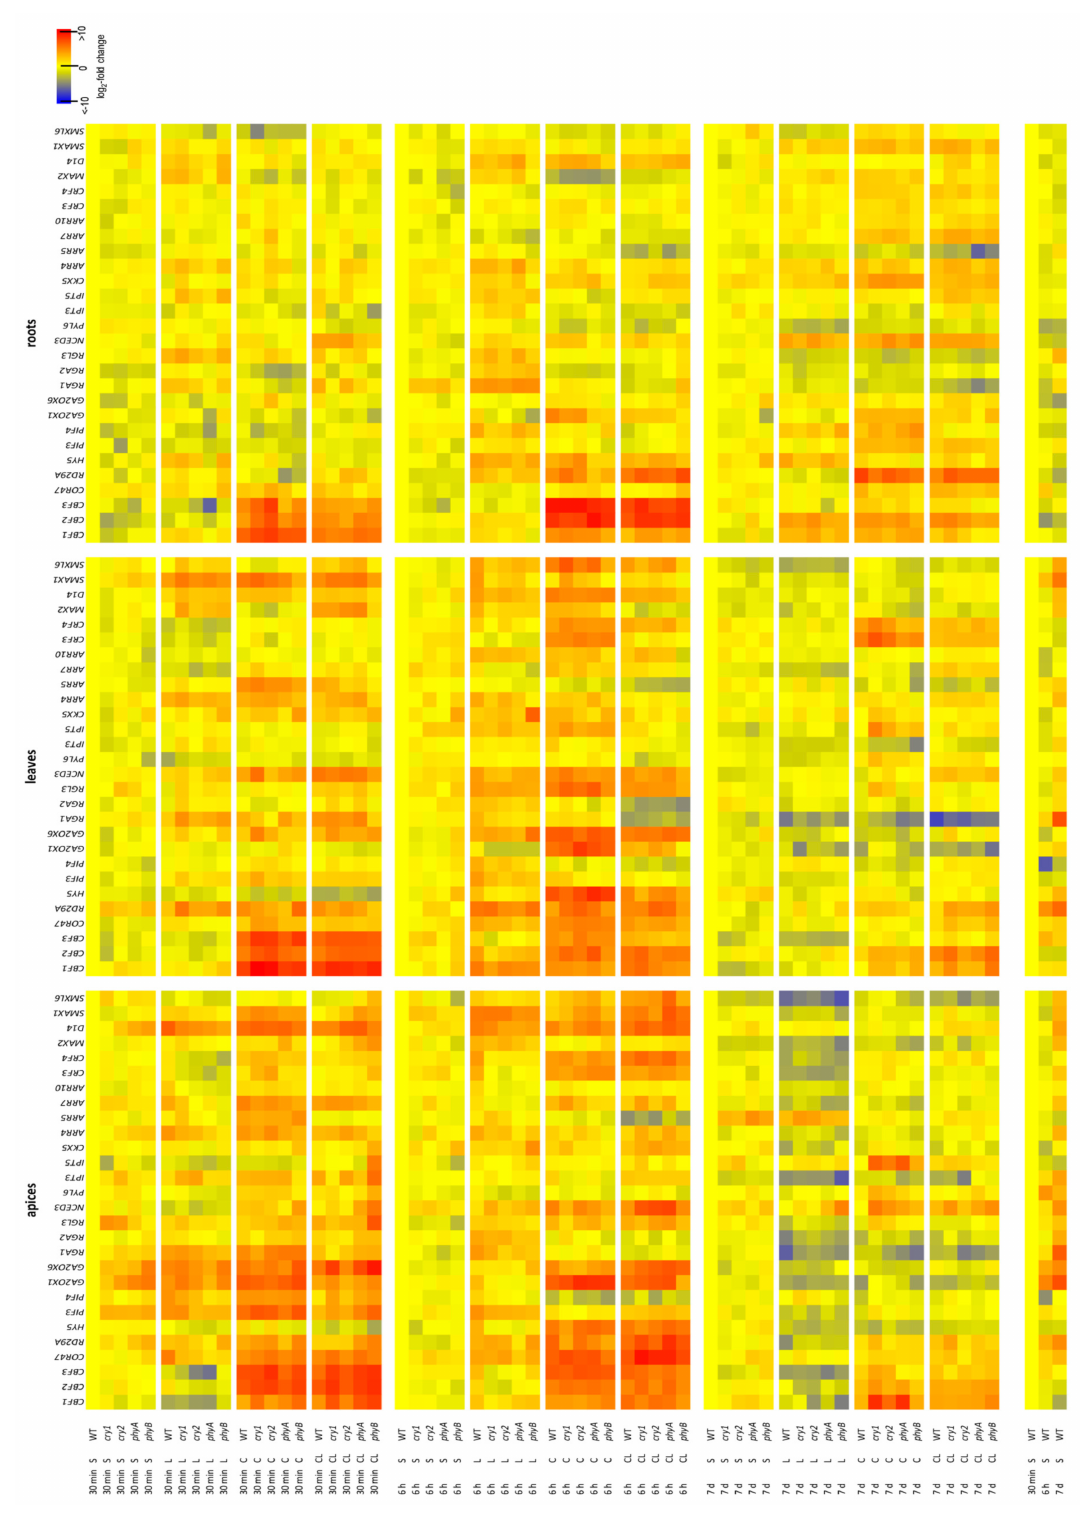
Figure 4. Heatmap of changes in transcript levels of selected stress-, phytohormone- and photoreceptor-specific genes. The expression was measured in shoot apices, leaves and roots of plants exposed to standard (S), low light (L), cold (C) and combined cold and low light (CL) conditions for 30 min, 6 h or 7 d. Four independent biological samples were evaluated. Data in heatmap are normalised to WT levels in S conditions separately for each tissue and time point. Means ± SD and other statistics are shown in Table